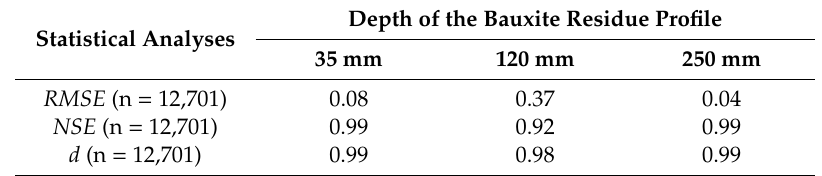
Figure 3. Observed and simulated bauxite residue water potential at depths of ( a ) 35 mm, ( b ) 120 mm and ( c ) 250 mm. Table 4. Statistical comparison of observed and simulated data for validation of the model. Statistical